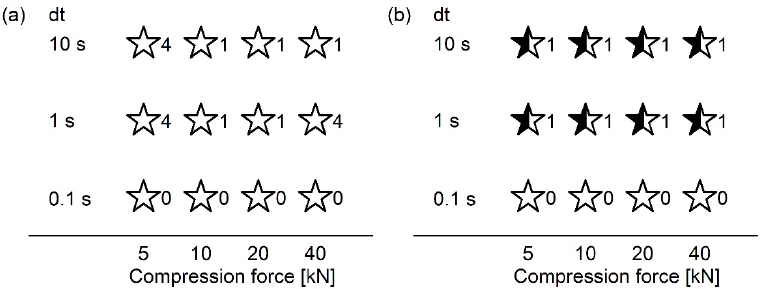
Figure 6. Stability of ASD tablets VA40 with MCC 200 during storage under two different conditions: ( a ) 23 °C/75% RH, ( b ) 40 °C/75% RH. Stars represent two types of recrystallization. Open stars show recrystallization in polymorphic form I. Semi-closed stars represent recrystallization in both form I and form II. The numbers indicate the weeks in which recrystallization was detected in the XRD measurements.